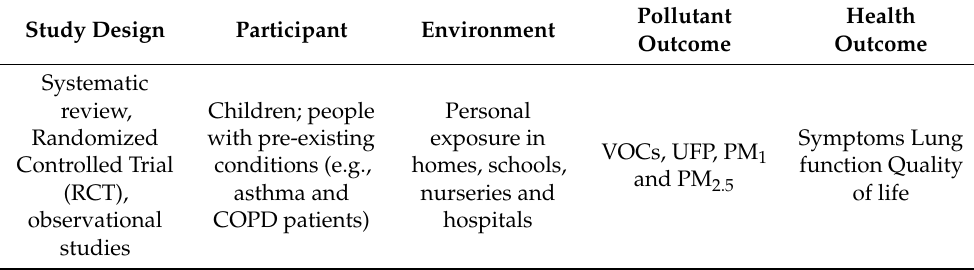
Figure 2. Preferred Reporting Items for Systematic reviews and Meta-Analyses (PRISMA) flow chart of study selection and inclusion. Table 1. Overview of studies eligible for inclusion in the systematic